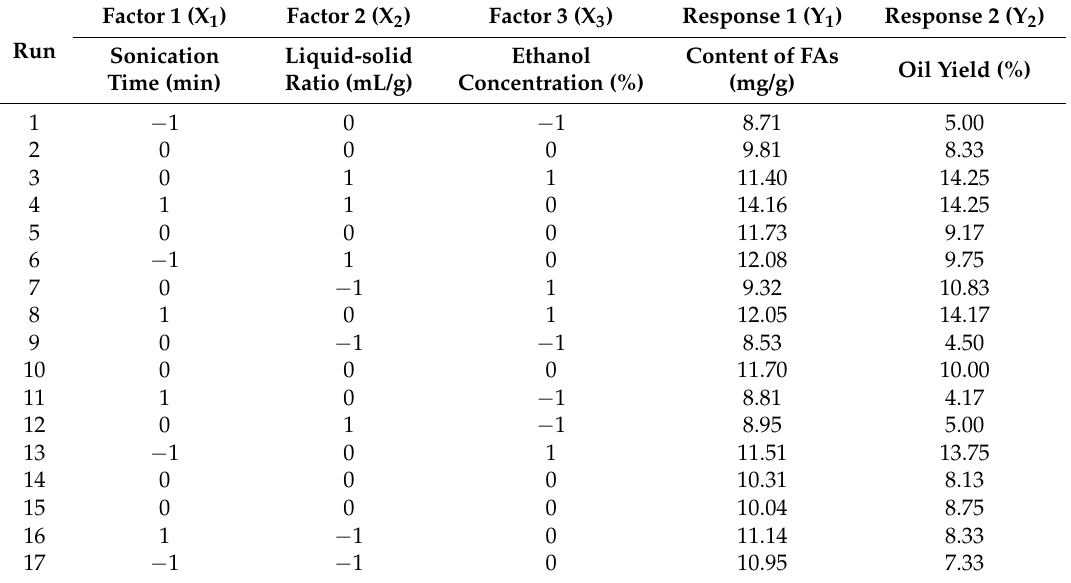
Table 7. BBD experimental design with the independent variables and experimental data for the